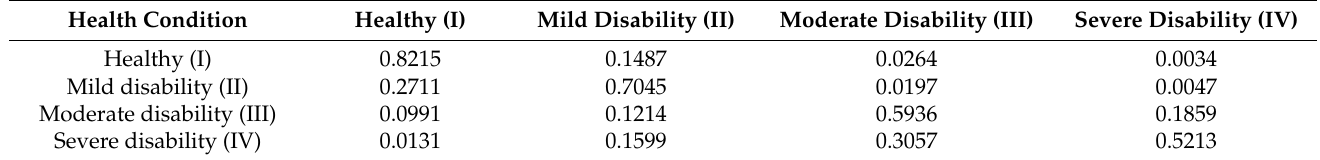
Table 3. Prediction of health status transition probability of the